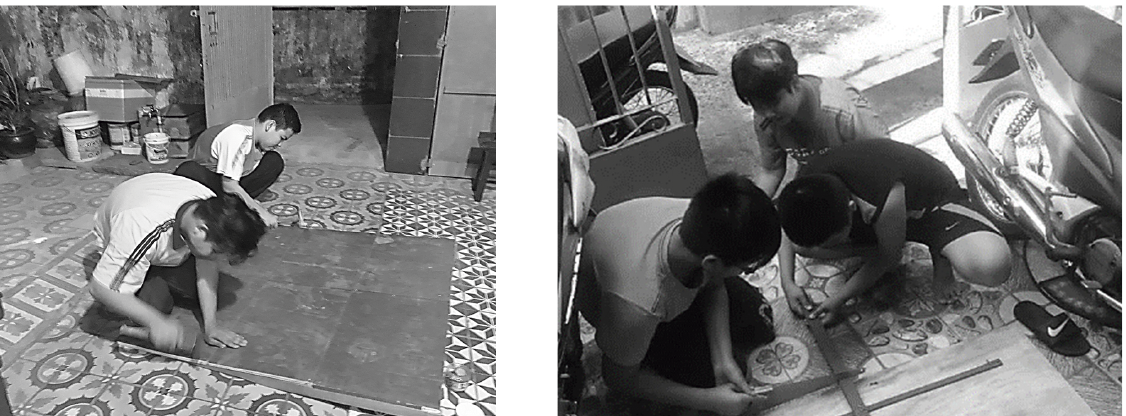
Figure 6. Worksheet 5. The construction of groups